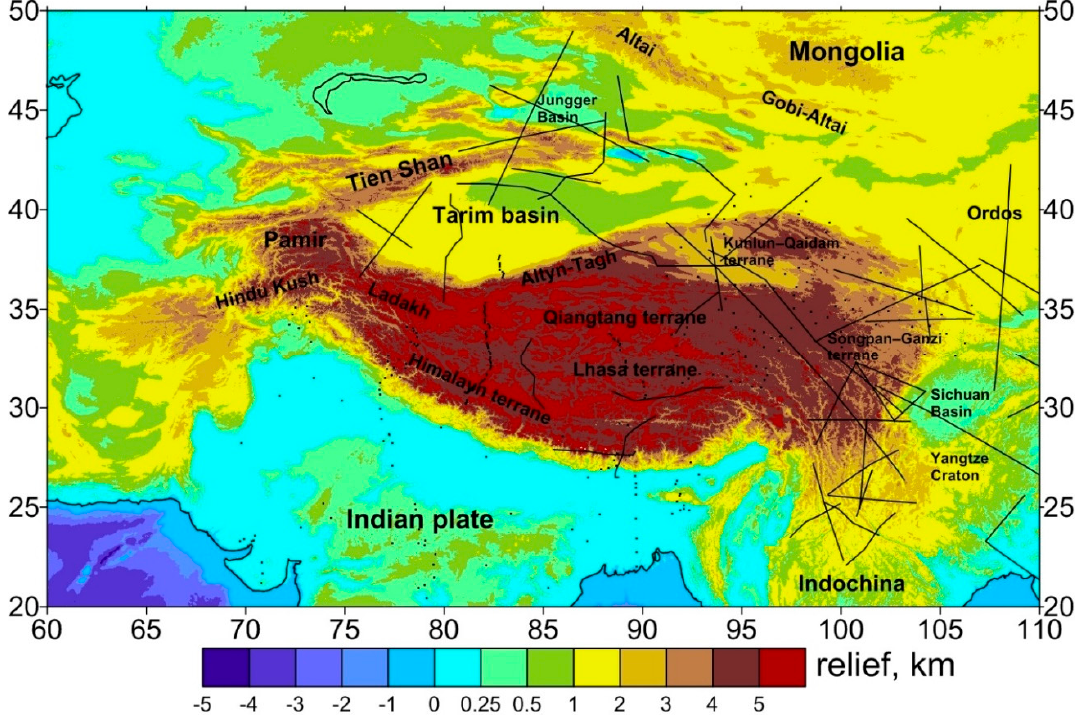
Figure 1. Geological setting of the study area. Black lines represent seismic profiles and black dots receiver functions.